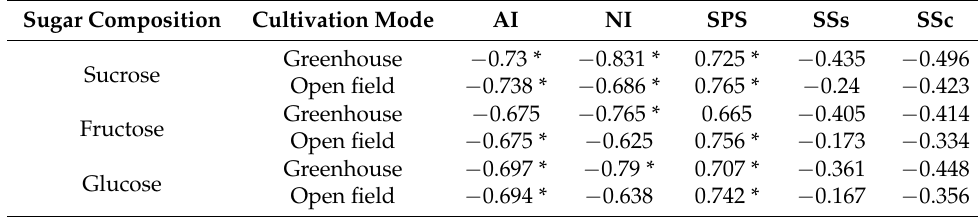
Table 1. Canonical correlation analysis between activity of sucrose metabolizing enzymes and sugar accumulation in bayberry fruit. acidic invertases (AI), neutral invertase (NI), sucrose-phosphate synthase (SPS), sucrose synthase in the synthesis direction (SSs), sucrose synthase in the direction of decomposition (SSc). Graphics marked * are significantly different ( p < 0.05) based on ANOVA. Sugar Composition Cultivation Mode AI NI SPS SSs SSc Greenhouse − 0.73 Sucrose